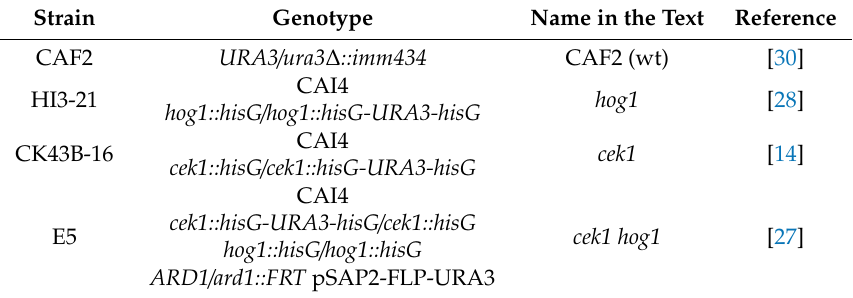
Table 1. C. albicans strain used in this